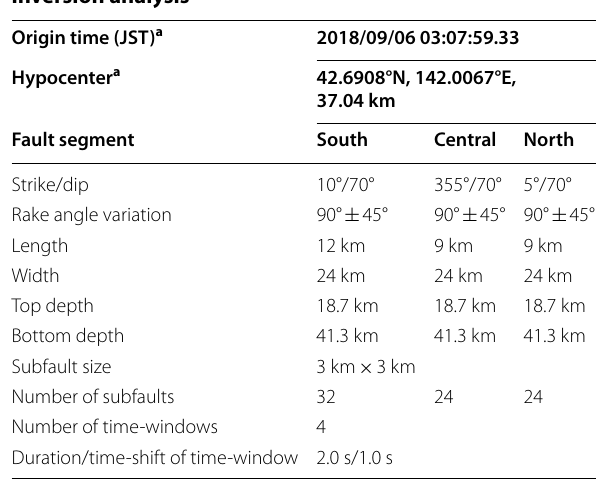
Table 1 Summary of fault model setting in waveform inversion analysis